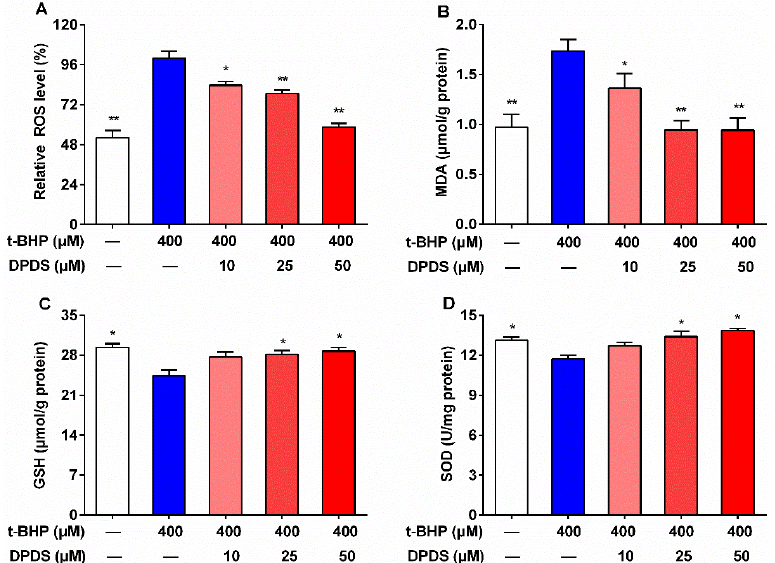
Figure 2. DPDS attenuated t-BHP-induced oxidative stress in HBZY-1 cells. The cells were incubated with t-BHP (400 µ M) alone or in combination with various concentrations of DPDS for 24 h. The levels of ROS ( A ), MDA ( B ), and GSH ( C ) and SOD activity ( D ) were measured. Values are presented as means ± SEM, n = 4. * p < 0.05, ** p < 0.01 versus the 400 µ M t-BHP group.